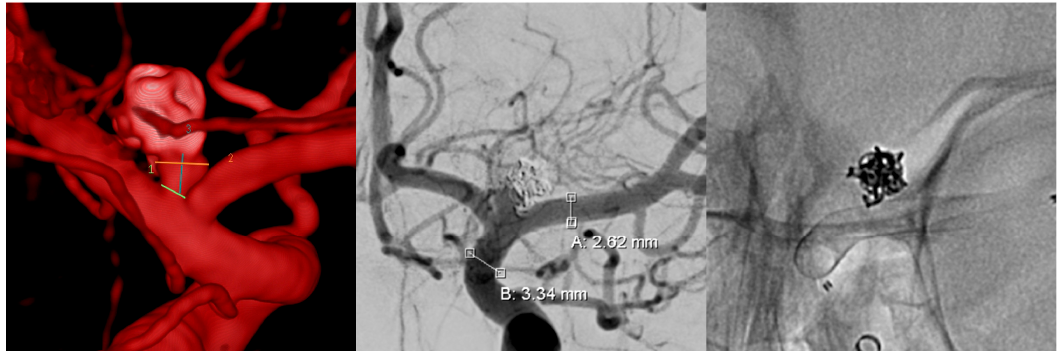
Figure 4. Digital subtraction angiography (DSA) images of the FDS implantation of the patient who experienced symptomatic vasospasm three weeks later. From left to right: three-dimensional (3D) rotational angiogram of the recurrent aneurysm, conventional posterior anterior (p.a.) angiogram in working projection, and corresponding radiogram of the uneventfully implanted FDS.